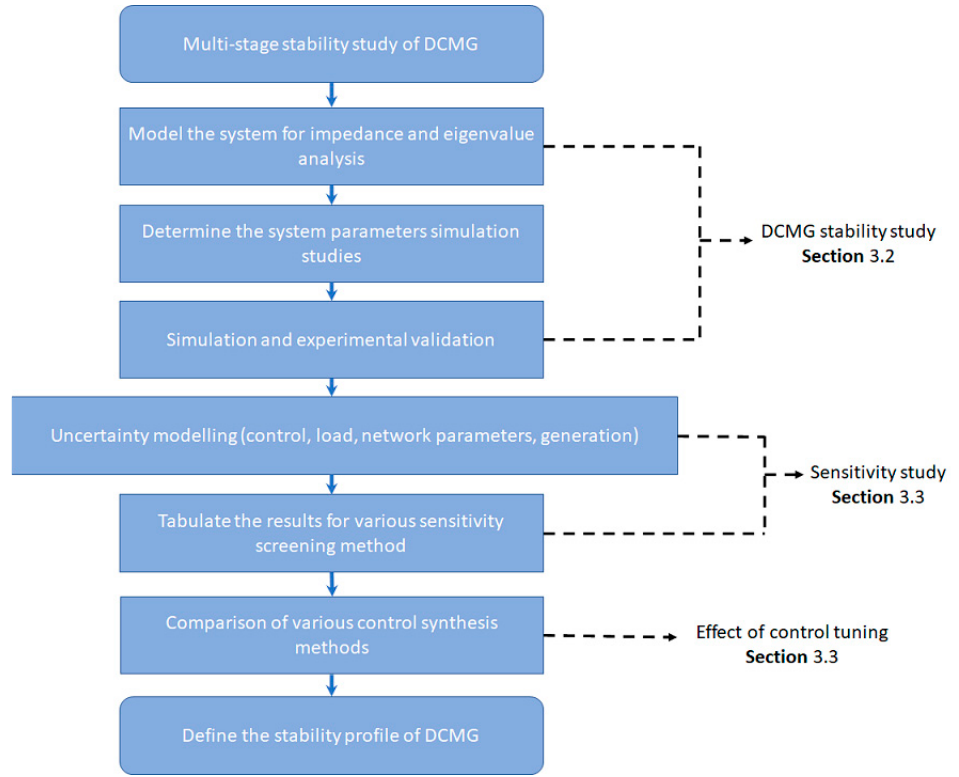
Figure 1. Flowchart of the study.